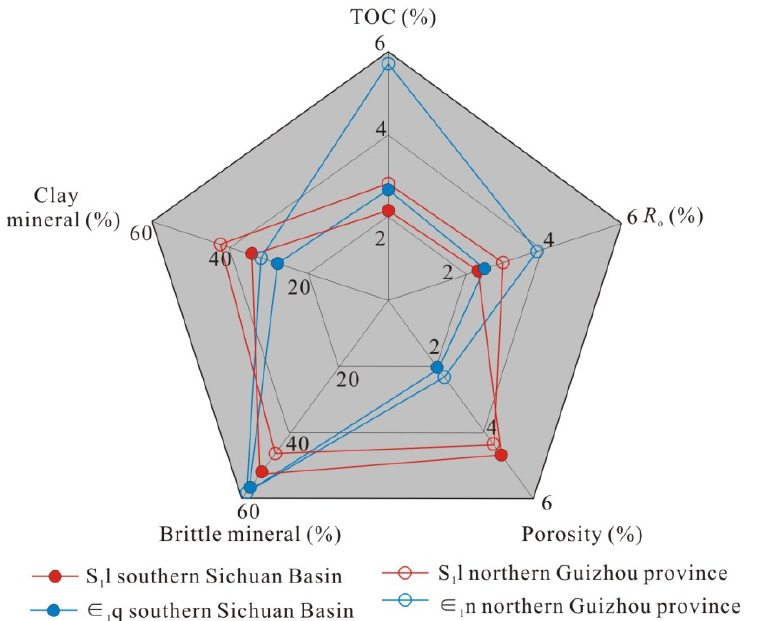
Figure 20. Comprehensive analysis of main controlling factors of the Lower Paleozoic shale from the upper Yangtze plate. upper Yangtze